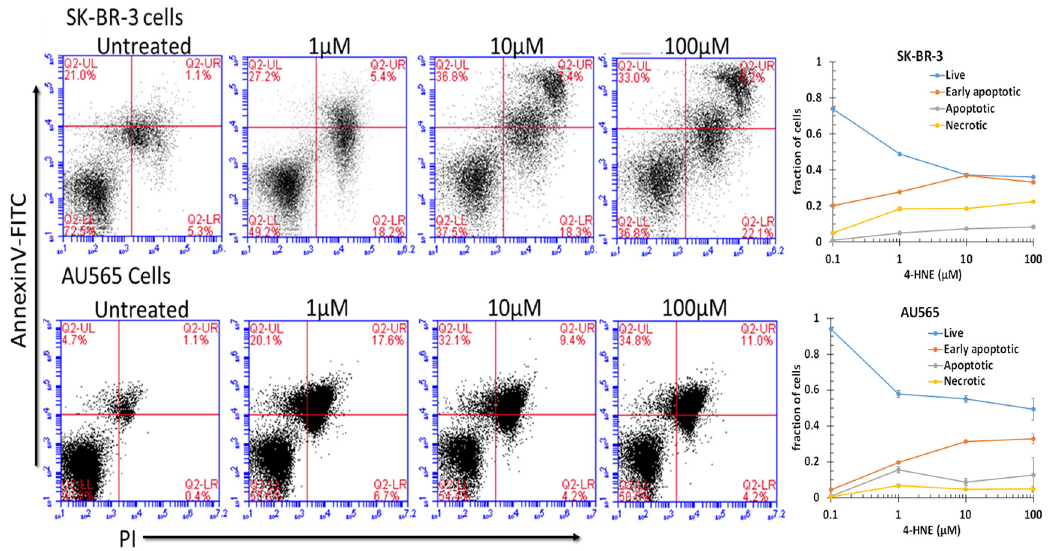
Figure 4. Role of 4-HNE in cancer cell death. To check the effect of 4-HNE on SK-BR-3 and AU565 cell survival, apoptotic cell death and necrotic cell death were measured using annexin and PI staining by flow cytometry. Cells were treated with different concentrations of 4-HNE for 24 h and processed as described in Materials and Methods. Viable cells were identified by gating on forward and side scatters. The logarithmic dot plots show the annexin- and PI-positive cells cluster in distinct groups after 4-HNE exposure. Quantitative analysis of the percent of cells in each gate after treatment is presented as the mean ± SD of three independent ments.